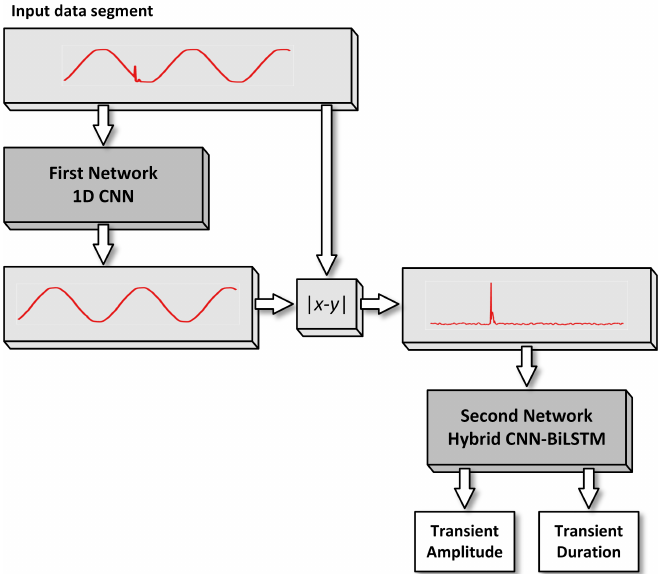
Figure 6. Topology of the proposed deep-learning architecture for the detection and characterization of power quality